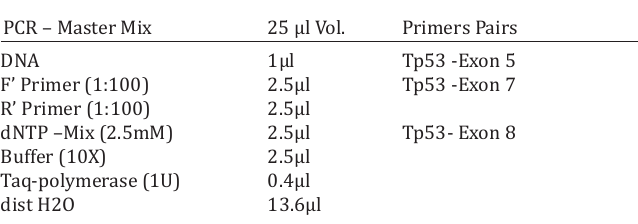
PCR master mixture conditions for